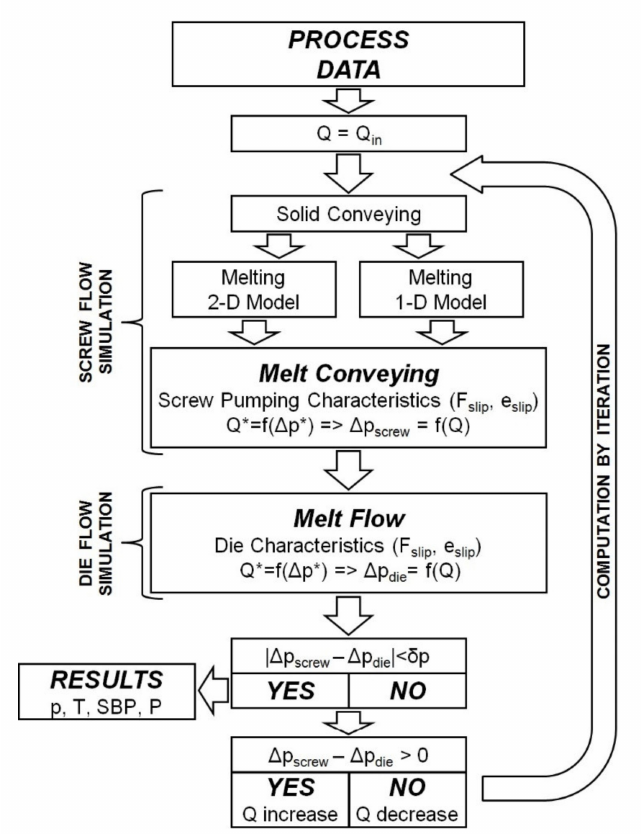
Figure 10. Algorithm of calculation: Q—polymer flow rate (extrusion throughput), Q in —initial polymer flow rate, ∆ p screw —pressure build-up in the screw, ∆ p die —pressure drop in the die, p— pressure, T—temperature, SBP—solid bed profile,